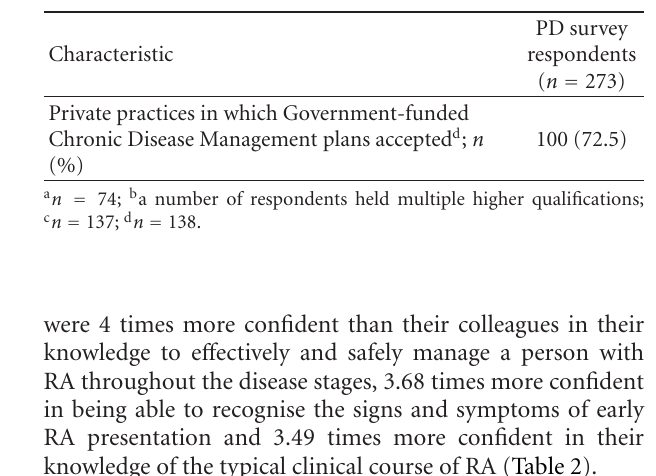
Table 1: Characteristics of